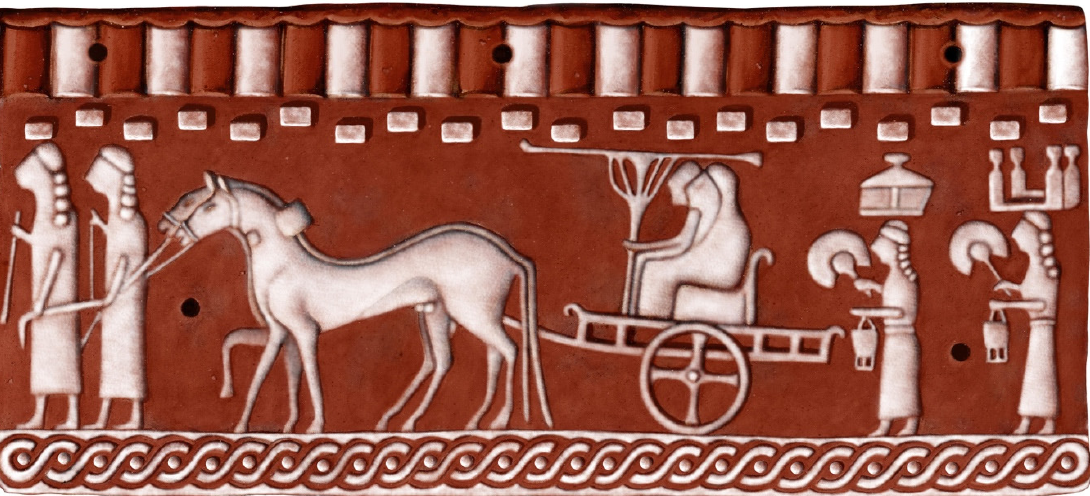
Figure 11. Illustrated reconstruction of the terracotta Procession frieze plaque type that decorated the Archaic Complex, 600-535 BCE (Image: Poggio Civitate Project).